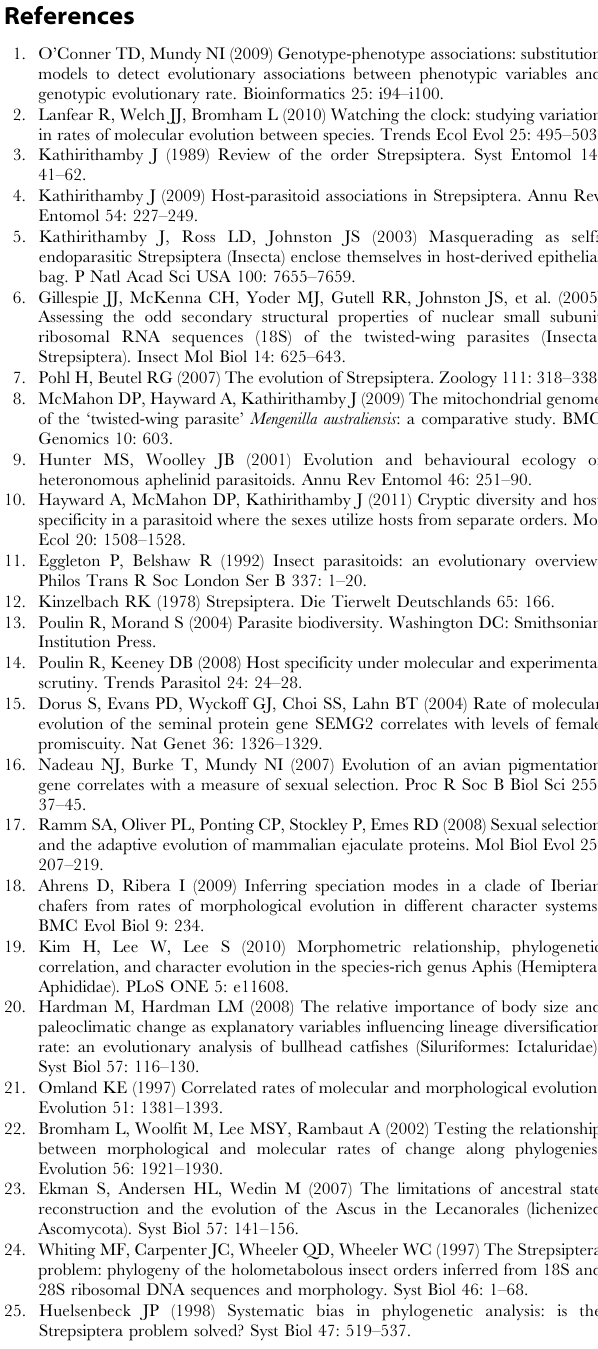
Table S5 Test of saturation by mitochondrial gene and codon position. *Statistics indicating little saturation. { Statistics with substantial saturation (bold). { Statistics indicating useless/ very poor sequence for phylogenetics (bold). Ts= symmetrical T- statistic. Tns= non-symmetrical